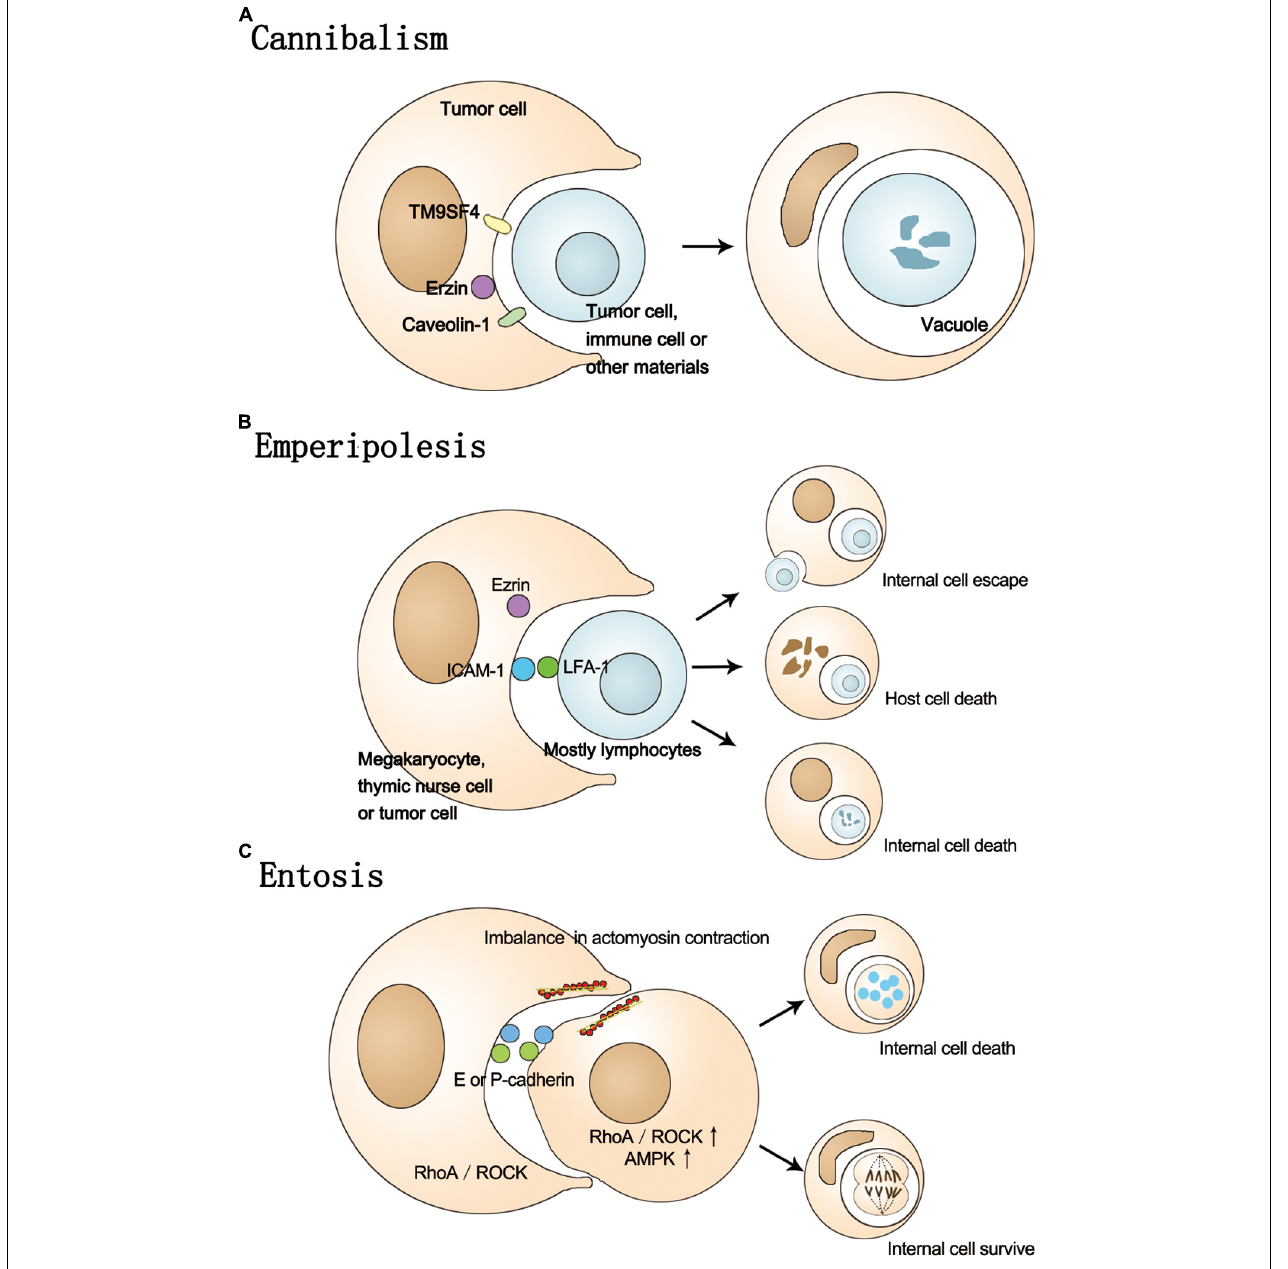
FIGURE 1 | The process of cannibalism, Emperipolesis, and Entosis. (A) In the process of cannibalism, host cells actively engulf themselves or other cells, causing the internal cell death. This process involves TM9SF4, Erzin, and caveolin-1. (B) The process of emperipolesis involves the Ezrin, LFA-1, and ICAM-1. The fate of inner cells can be escaping from the host or death and host cells can also be destroyed by internal cells. (C) Entosis is a homotypic cell-in-cell phenomenon involving E/P-cadherin, Rho-ROCK-actin/myosin pathway and imbalance in actomyosin contraction. The ROCK and AMPK activity is higher in internal cells. The fate of internal cell can be death or